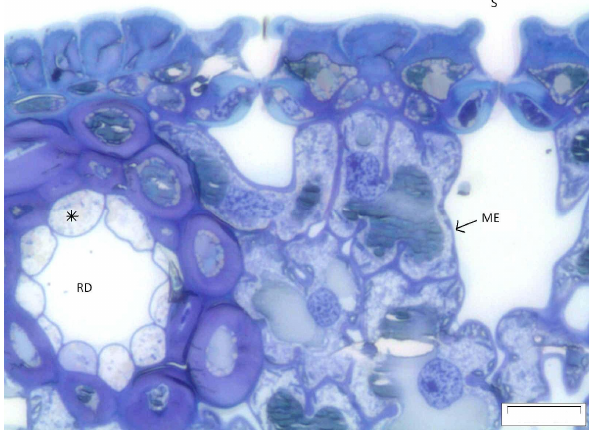
Fig. 1. A light micrograph of a Scots pine needle cross section. The sectioning was done from a resin-embedded needle and the 2µm thick section was stained with Toluidine blue according to B¨ack et al. (1994). RD=resin duct; ME=mesophyll cell; S=stoma; *=epithelial cell.